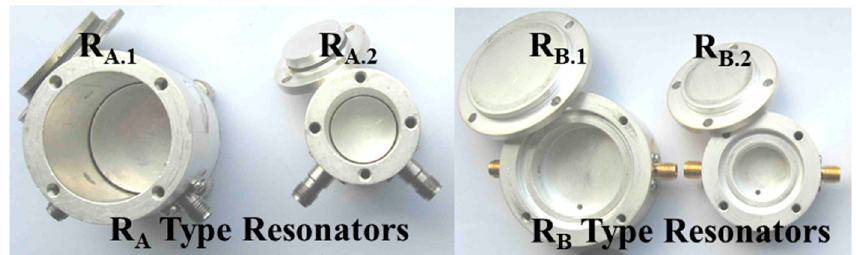
Figure 2. R A - and R B -type resonators (the diameters- D A.1 = 30.5 mm, D A.2 = 18.2 mm, D B. 1 = 30.5 mm, D B.2 = 18.3